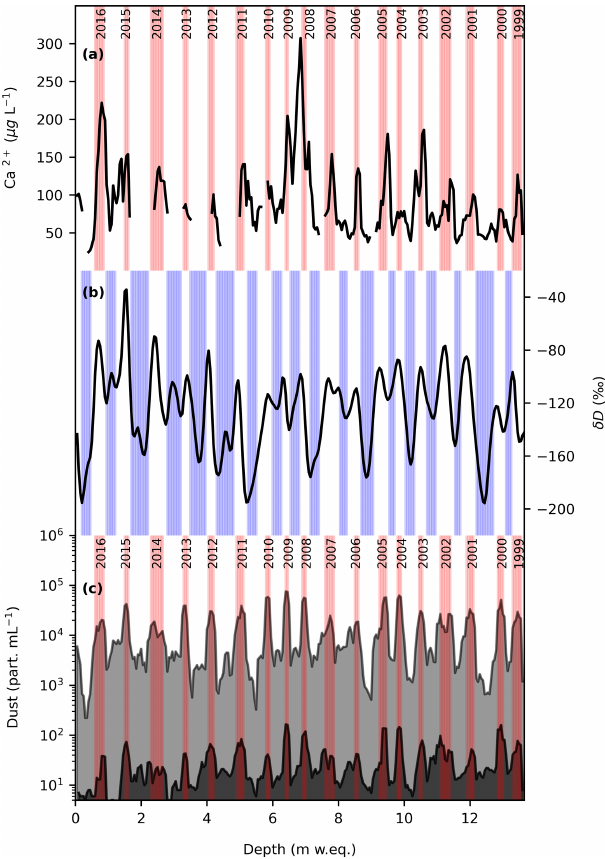
Figure 2. Dating of the Nevado Illimani firn core by annual layer counting (ALC) based on different proxies discussed in the text: (a) ionic calcium, (b) δ D, and (c) total and giant dust particle con- centrations (light and dark gray, respectively; both are in logarith- mic scale). Red and blue shaded vertical bands correspond respec- tively to the dry and wet season for each calendar year. All data are reported as the 3-point running average of data resampled at 0.05mw . e